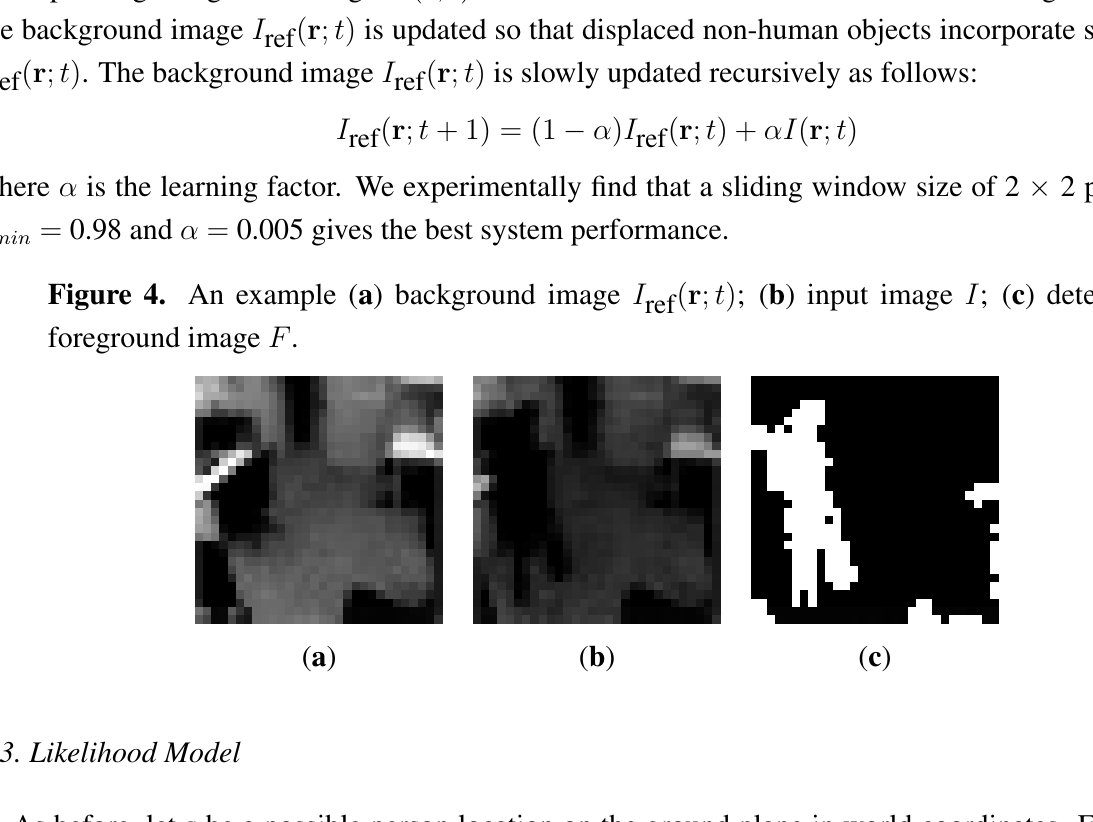
( r ; t ) ; ( b ) input image I ; ( c ) detected ref